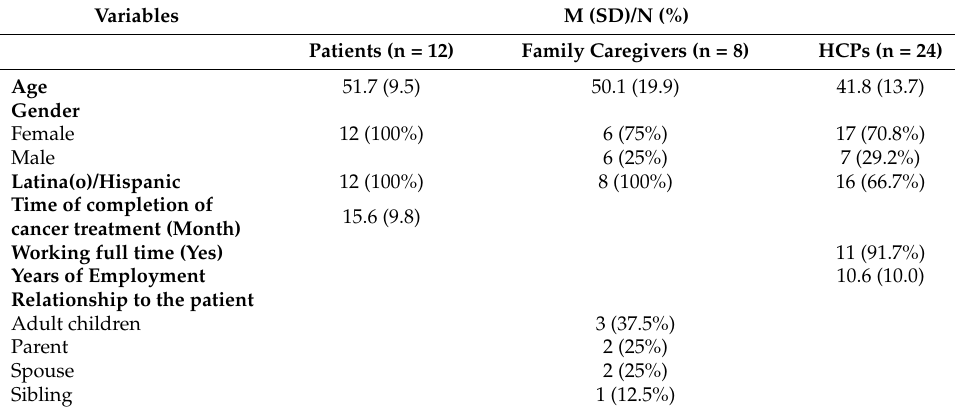
Table 1. Participant characteristics (N =